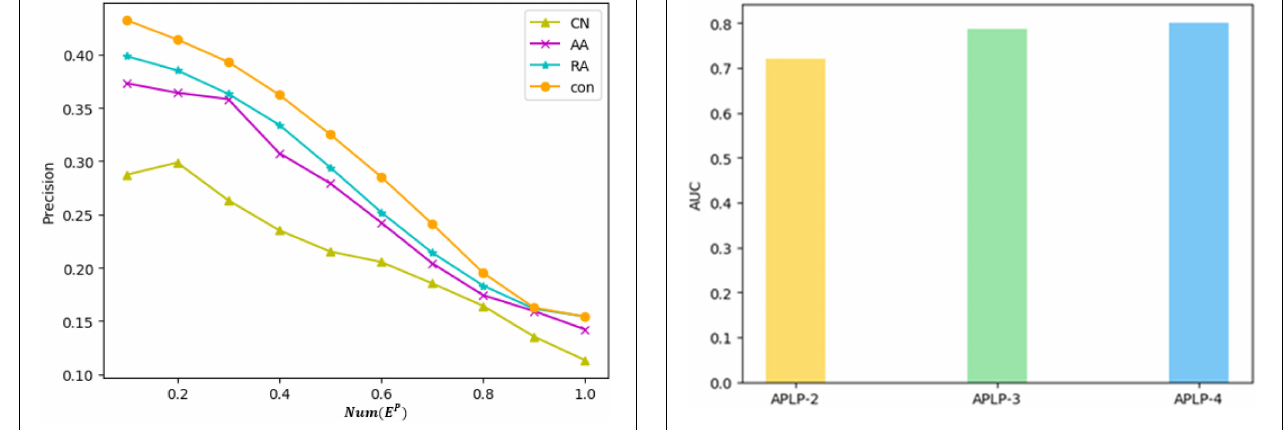
FIGURE 11 | Precision comparison of different metrics.